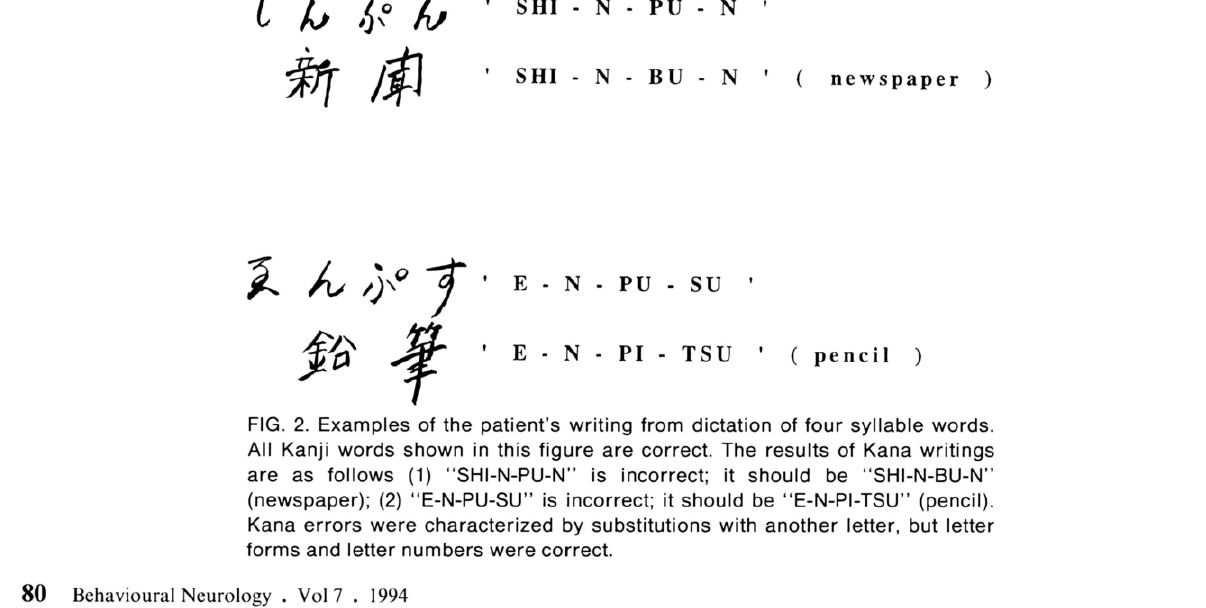
FIG. 2. Examples of the patient's writing from dictation of four syllable